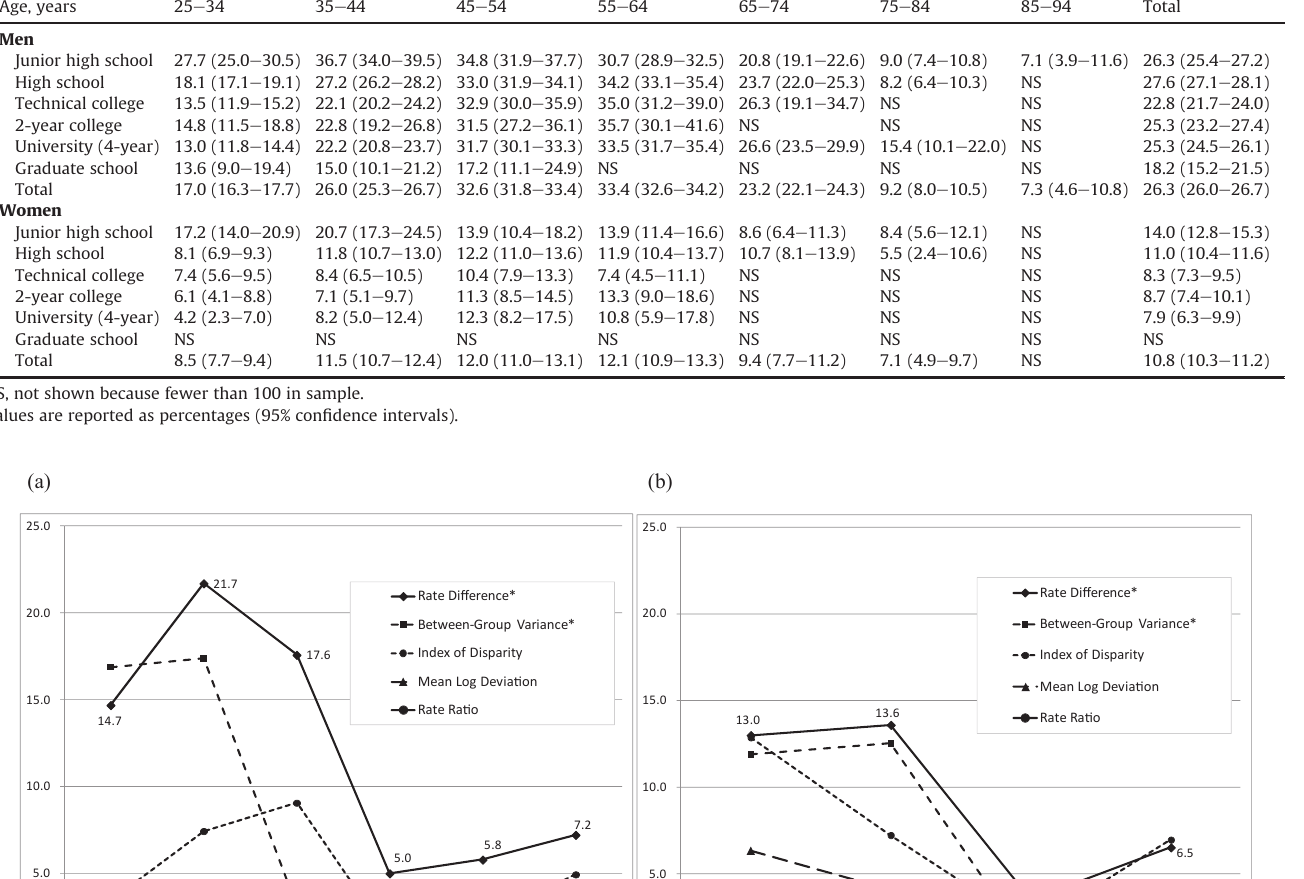
Table 2 Heavy smoking prevalence among daily smokers according to age, sex, and education groups in 2010. Age, years